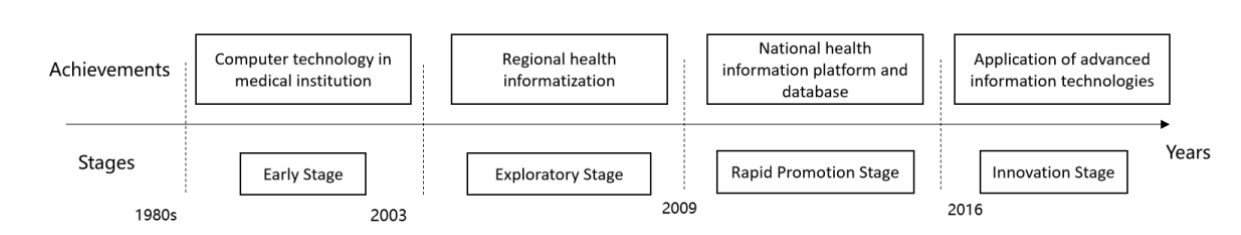
Figure 2. The development history of health informatization in